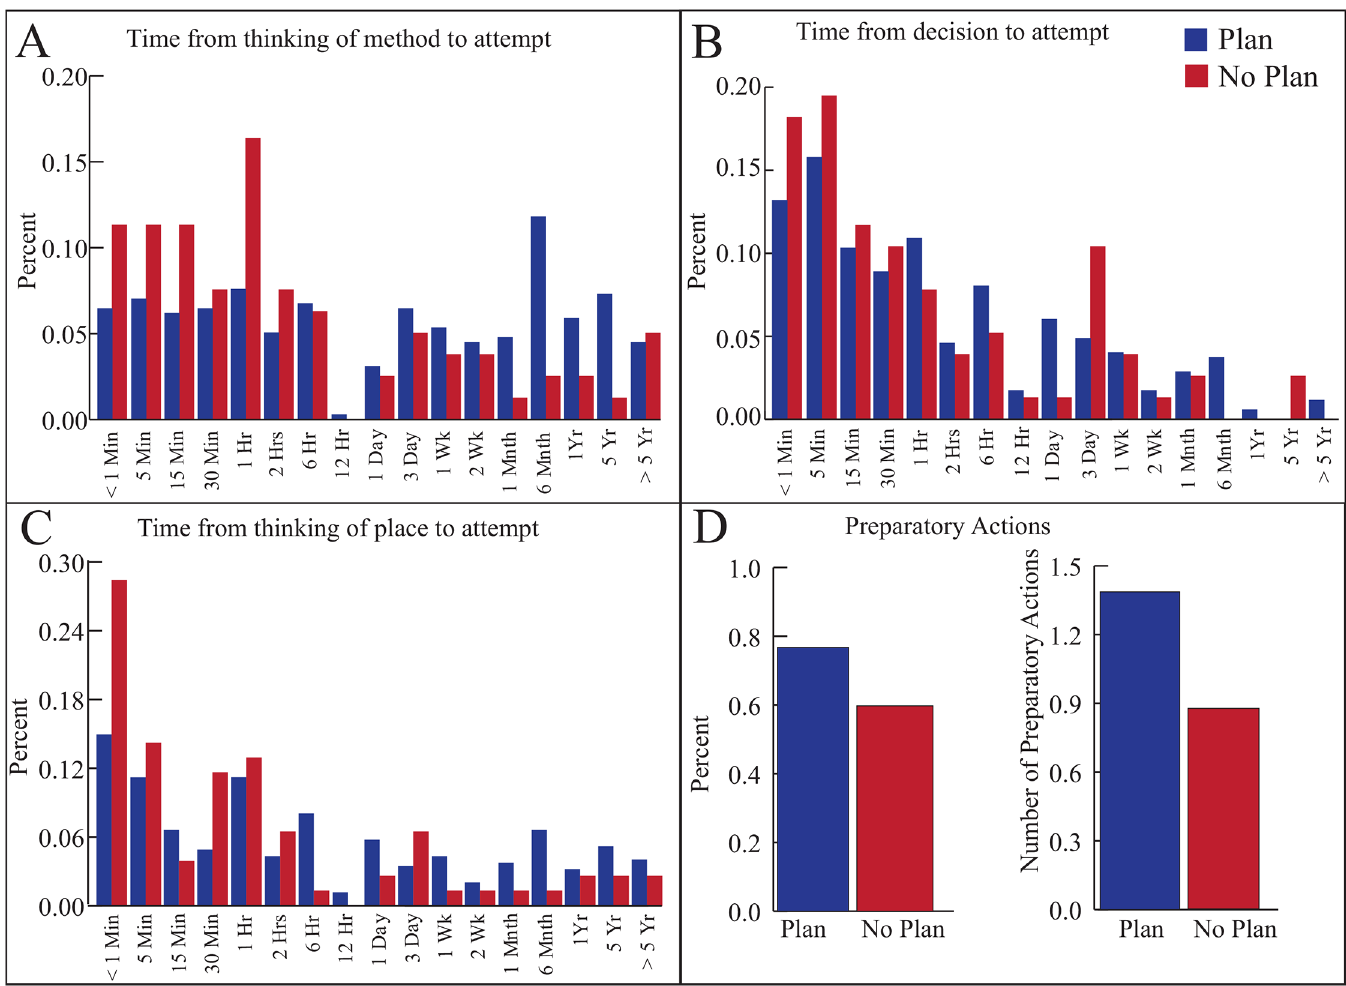
Fig 3. Characteristics of suicide planning among participants who attempted suicide and either endorsed a single-item plan or did not. For those that endorsed a single-item lifetime suicide plan (blue) and for those that denied a single-item lifetime suicide plan (red), the distributions of (A) the amount of time between thinking of the method and attempting suicide, (B) the decision to attempt and attempting suicide and (C) thinking of place to attempt suicide and attempting suicide and (D) the percentage of participants that made any preparatory actions and the mean number of preparatory actions prior to a suicide attempt. If participants interpreted a “ suicide plan ” similarly, one would expect minimal overlap between distributions of planning characteristics for single-item “ planners ” and “ non-planners. ” Instead, each of the distributions overlap substantially (71 – 92%) using the bins in the current plot, suggesting participants do not reliably interpret the single-item suicide planning